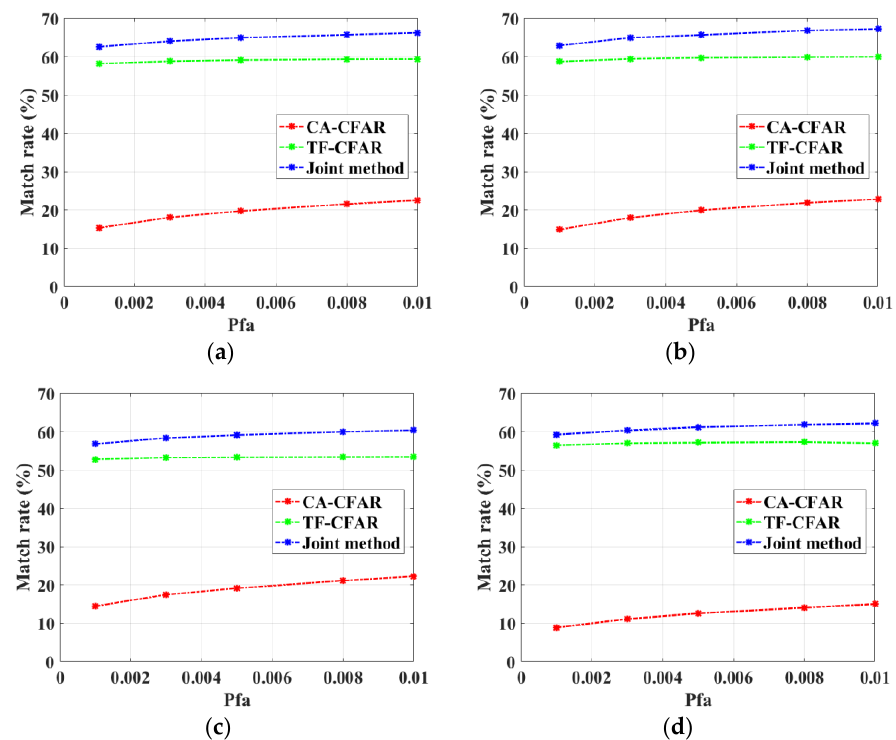
Figure 16. Match rate results of the three methods under different P fa on ( a ) 24 September, ( b ) 25 September, ( c ) 26 September, and ( d ) 27 September.